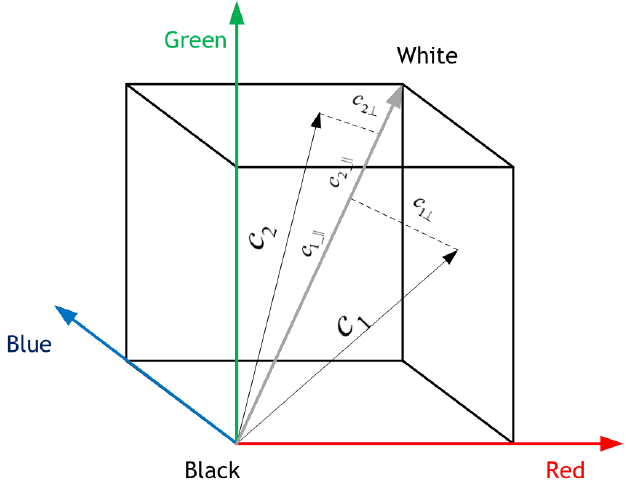
Figure 1. RGB vectors and the color